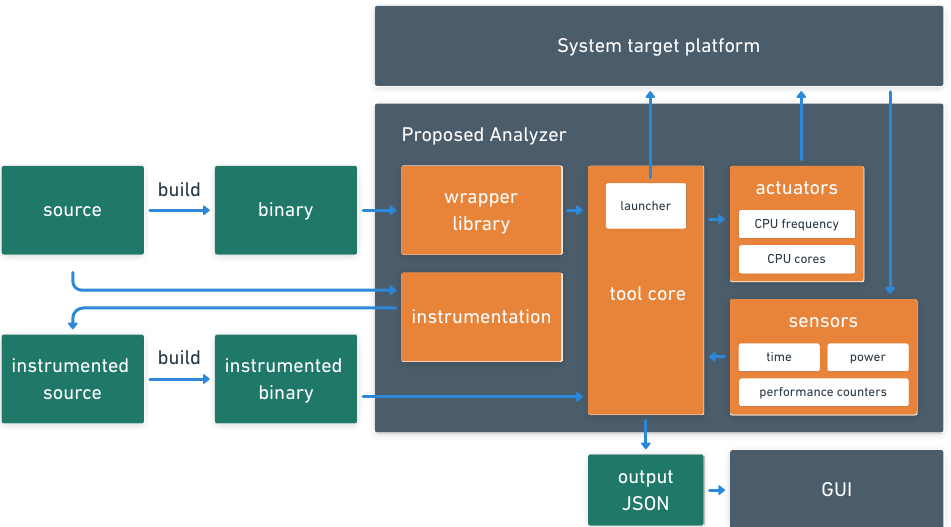
Figure 1. Architecture showing the interconnections of the central parts of the tool. Either binary (using the wrapper library) or an instrumented source code, the target application can be launched on the target platform by the tool core following the configuration parameters chosen by the user while deploying actuators/sensors. The resulting data collection is stored in Json file format for post analysis and visualization